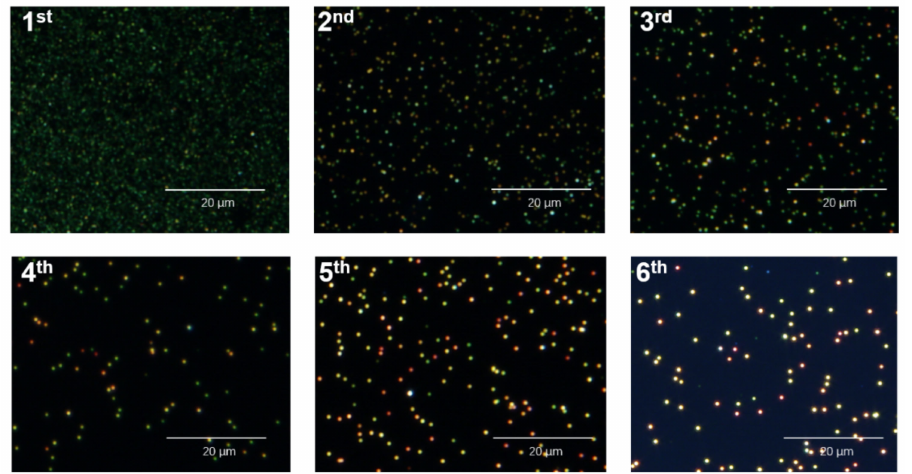
Figure 2. Dark-field images of AuNPs with different growth